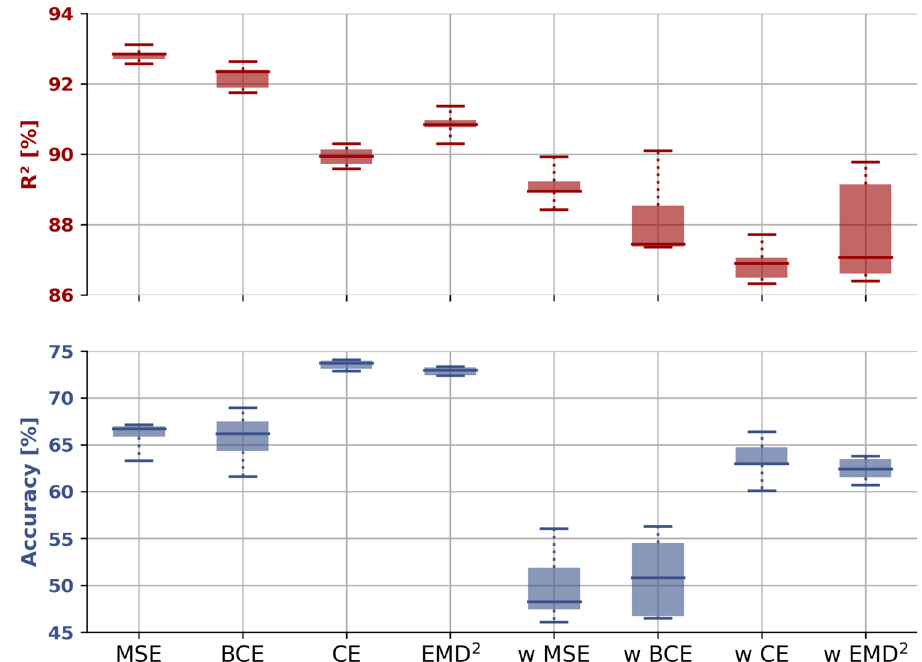
2 Figure 2. Test R -score (red upper box plots) and accuracy (blue lower box plots) distributions. w indicates a weighted loss. Each distribution summary is compiled from 5 model runs, where each model is selected based 2 on the highest test R -score.